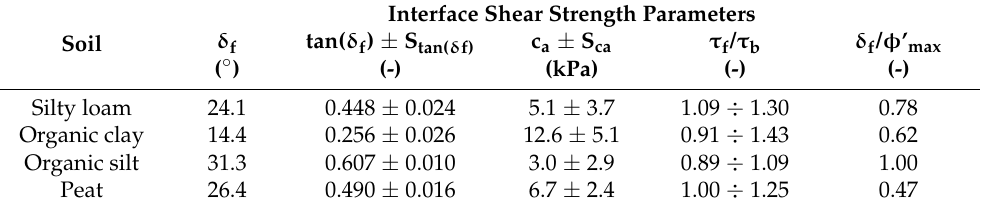
Figure 6. Examples of normalized shear strength during forward–backward shearing for ( a ) smooth interface and ( b ) rough interface. Table 5. Friction characteristics of smooth concrete–soft soil interfaces.